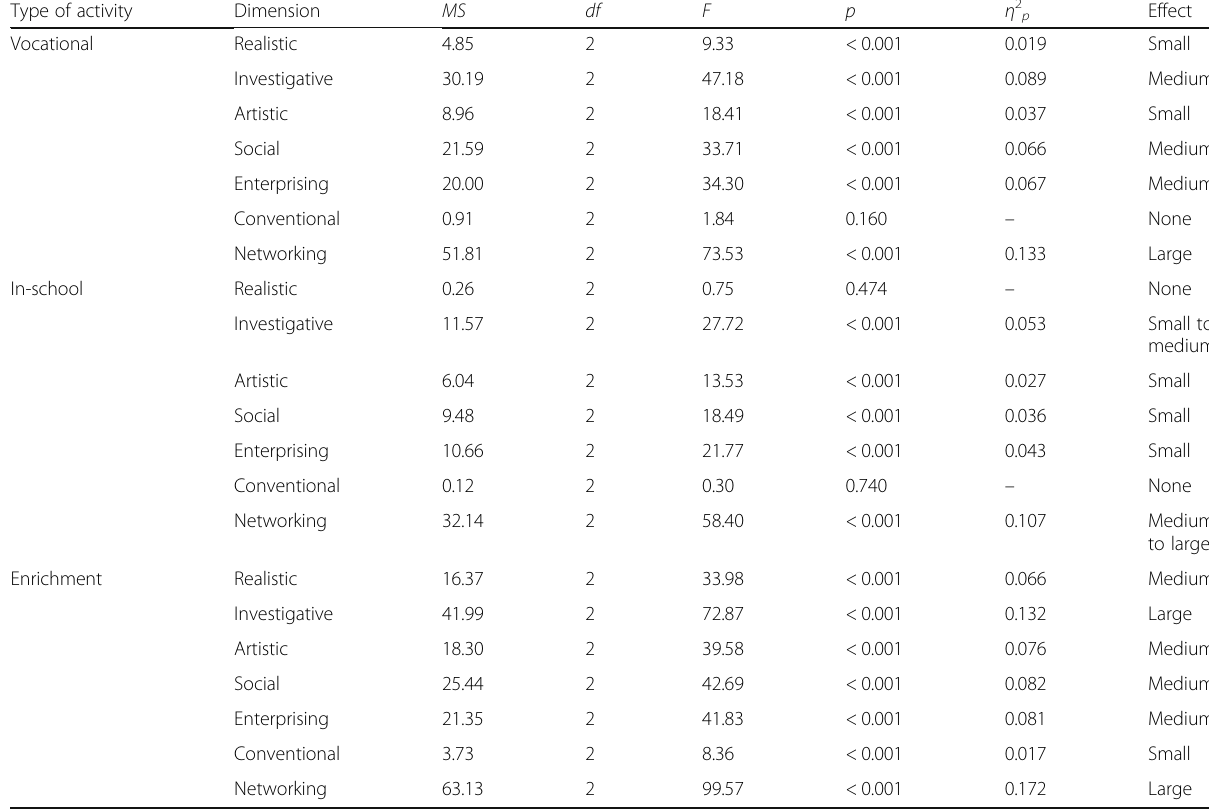
Table 1 Mean differences and results of analyses of mean differences of IJSO participants, non-participants, and participants in other science or mathematics competitions on the RIASEC+N dimensions for in-school activities, enrichment measures, and for vocational interests. Assessment of the effsize (small to large) according to Cohen